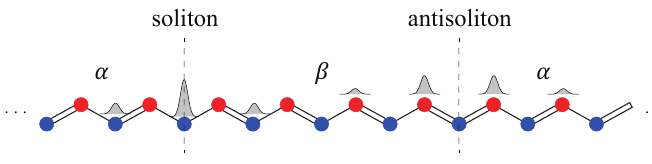
Figure 3. In a periodic system with two domain walls, a soliton-antisoliton pair must exist. Their site probability densities are shown. For a soliton (antisoliton), the probability density is finite on A (B) carbon atoms